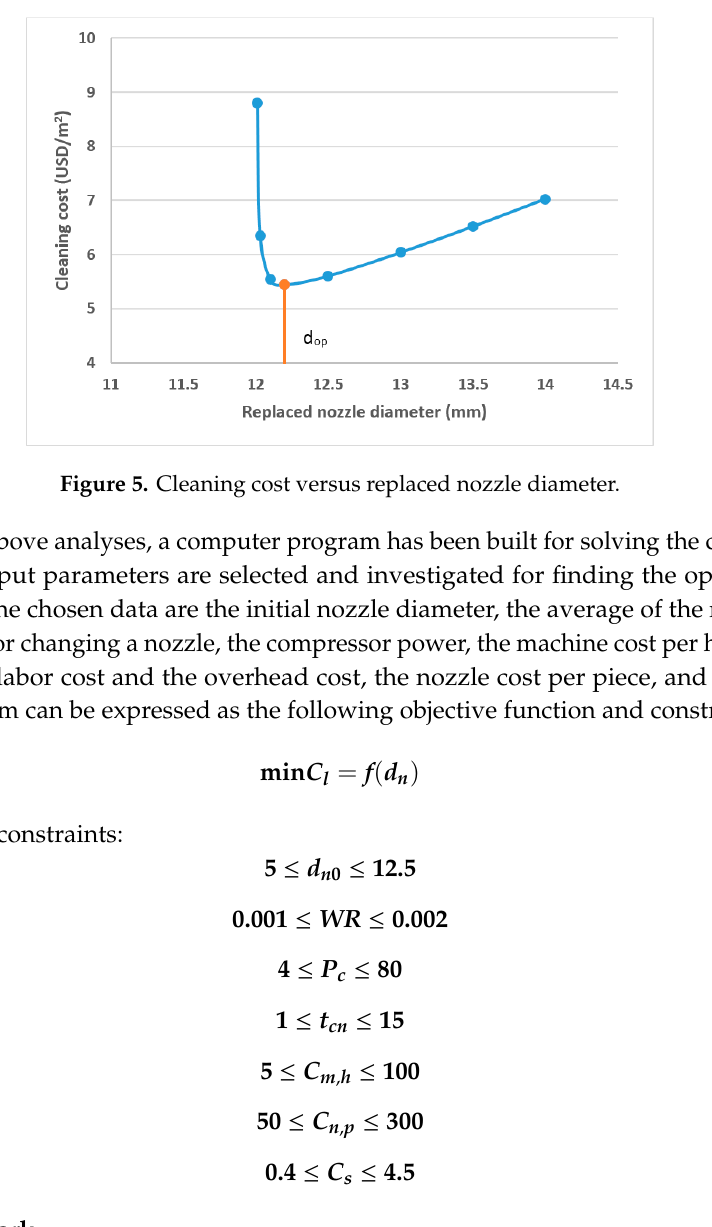
Table 1. Input parameters.